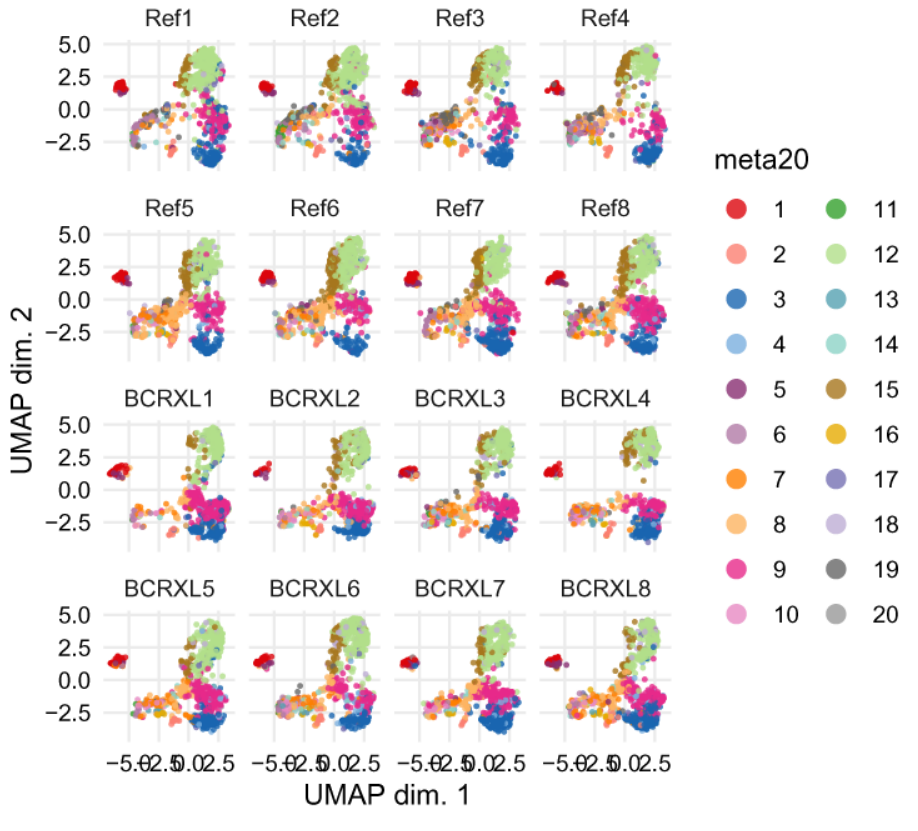
Figure 11. UMAP as in Figure 10, but stratified by